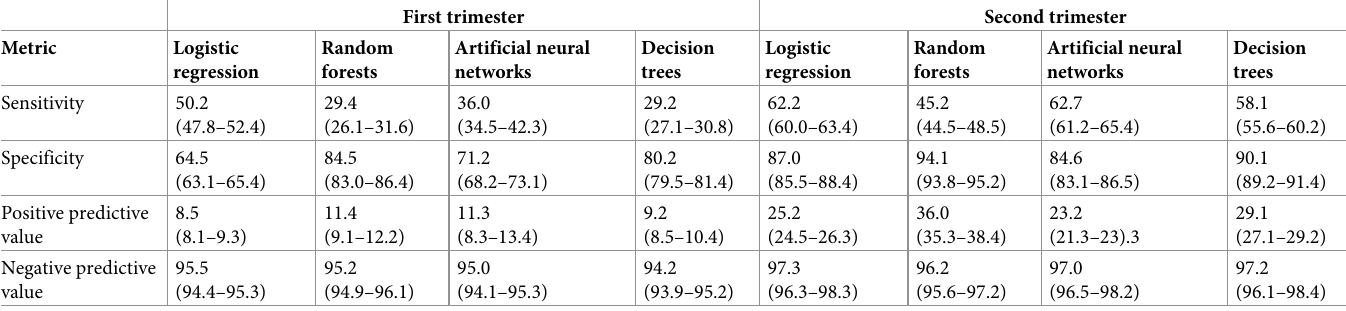
Table 4. Predictive power of preterm birth models during the first and second trimesters in nulliparous